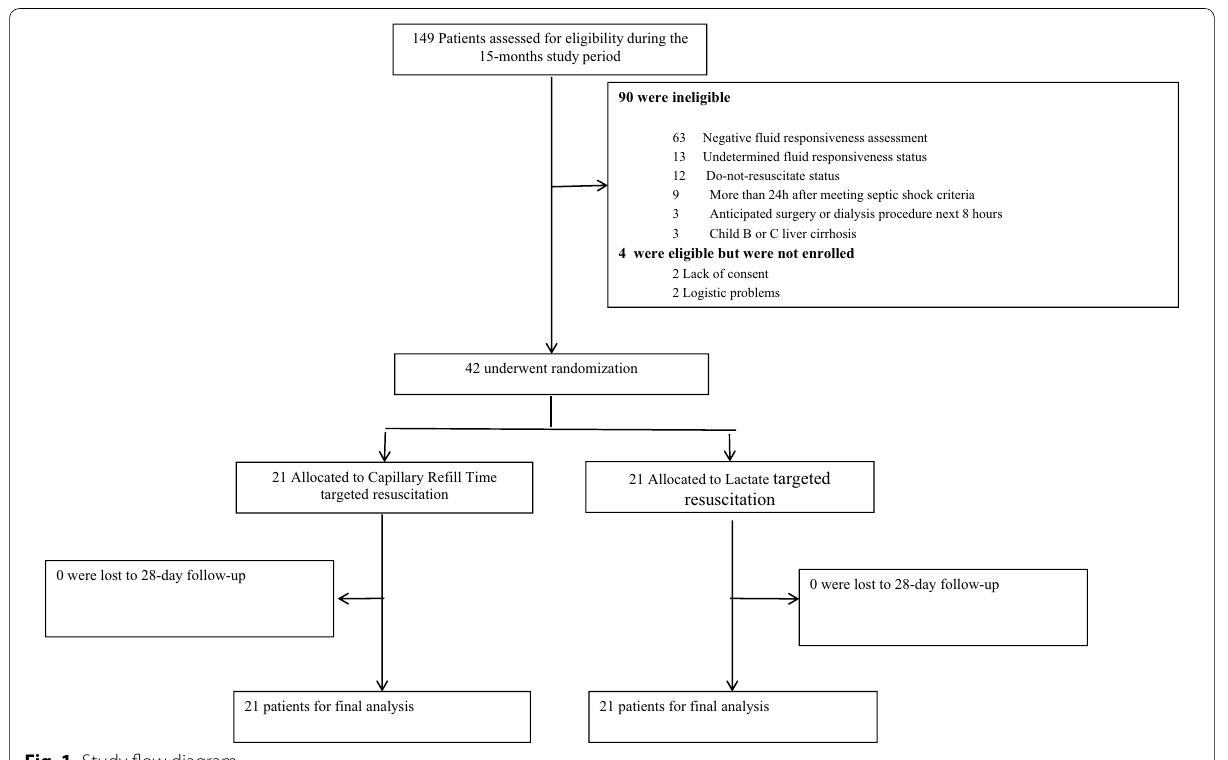
Fig. 1 Study flow